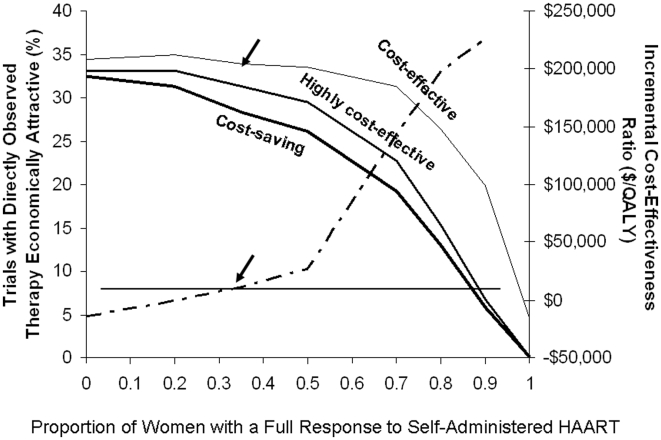
Sensitivity Analysis of Increasing Baseline Effectiveness of Self-Administered Antiretroviral Therapy.The proportion of women with a full response to self-administered antiretroviral therapy (i.e., 2.0 log10 reduction in viral load) is presented on the X-axis. The left-sided Y-axis indicates the proportion of 200-person clinical trials that find directly observed therapy to be cost-effective for various willingness-to-pay thresholds (thick black curve, WTP = $0; medium black curve, WTP = $50,000; thin black curve, WTP = $150,000). Average incremental cost-effectiveness ratios for directly observed therapy, relative to self-administered antiretroviral therapy (dark dashed curve) are presented on the right-sided Y-axis; values below $0 indicate that directly observed therapy is a cost-saving health intervention. As the proportion of women who have a full response to self-administered HAART increases, there is a decrease in the proportion of women for whom DOT is cost-effective. An increase in the willingness-to-pay threshold leads to an increase in the proportion of women who find this intervention cost effective. Arrows indicate base-case values.